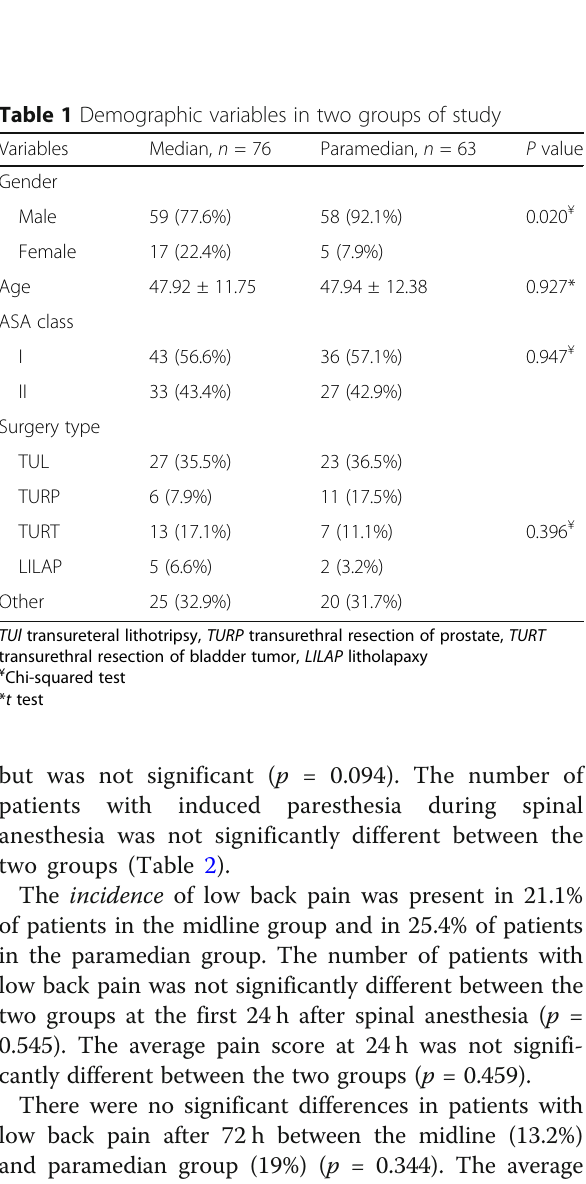
Table 1 Demographic variables in two groups of study Variables